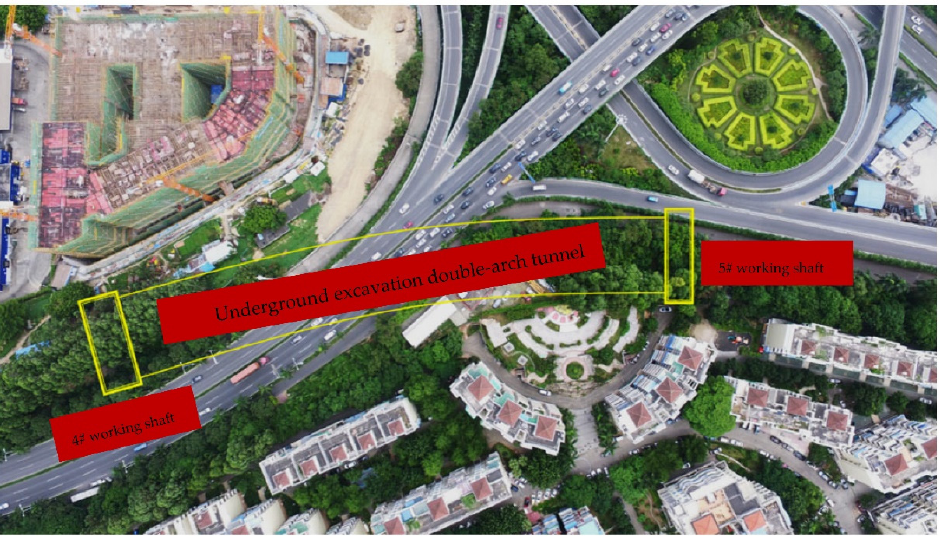
Figure 1. Schematic diagram of the plane position of the underground excavation double-arch tunnel. The minimum buried depth of the main tunnel is about 5 m and the maximum buried depth is about 15.45 m. The designed single tunnel has a headroom width of 14.60 m and a headroom height of 10.15 m. The full cross-sectional area of the tunnel is 119.27 m 2 . three heading excavation method. The side heading tunnel has a cross-sectional area